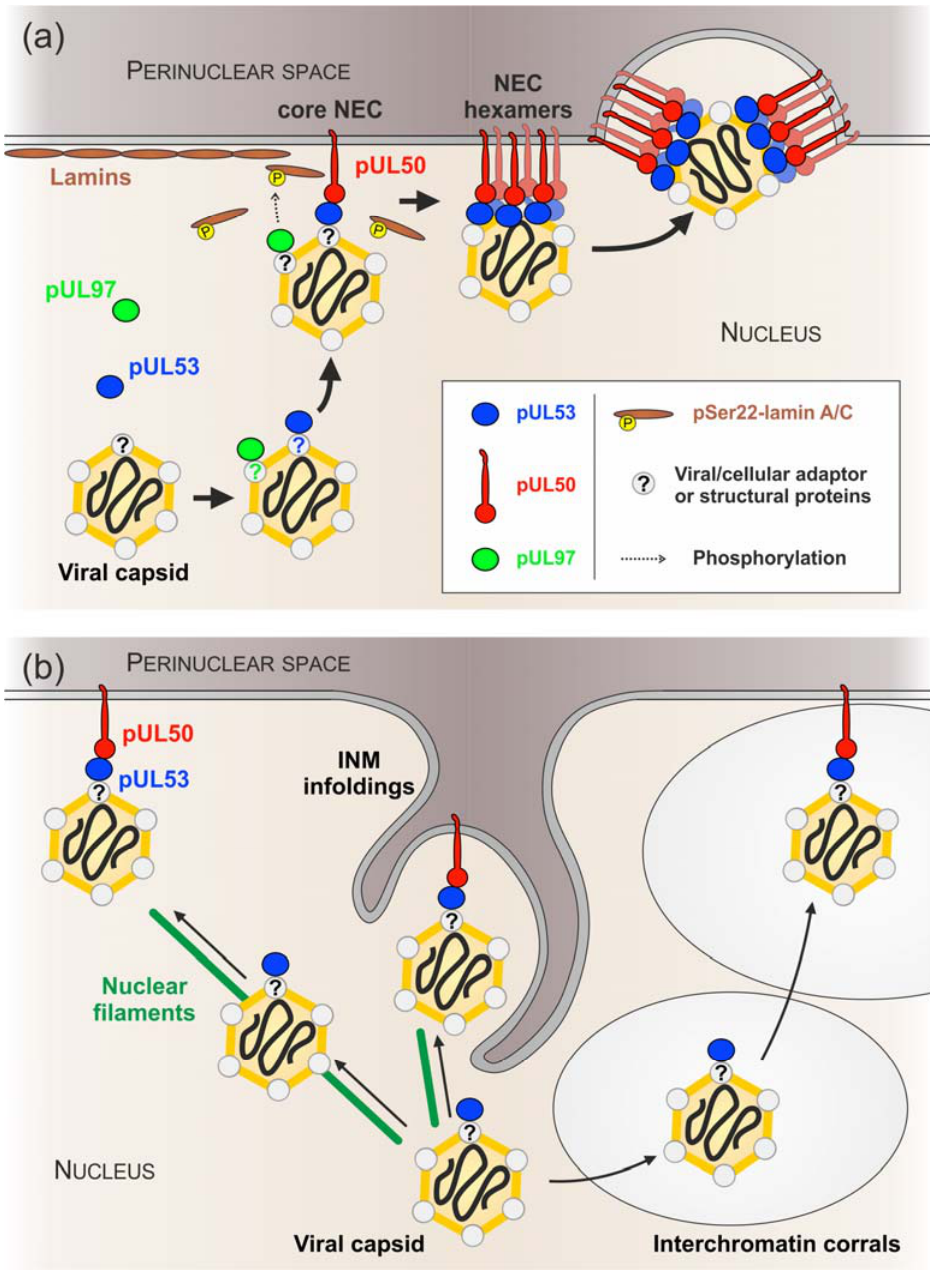
Figure 7. Schematic presentation of theoretical options that may lead to the recruitment of HCMV capsids to INM budding sites. ( a ) First, core NEC component pUL53 and NEC-associated protein kinase pUL97 bind to viral capsids in the nucleoplasm. Binding might be mediated directly via structural viral proteins (e.g., MCP, SCP, pUL85, or CVSC proteins) or indirectly via viral or cellular adaptor proteins. Second, pUL53-coated capsids dock to membrane-anchored pUL50 under formation of the core NEC. Capsid-associated pUL97 might be responsible for phosphorylation of remaining lamin A/C molecules providing access to the INM. Hexameric core NEC assemblies finally initiate budding into the perinuclear space; ( b ) Depiction of putative mechanisms of how HCMV capsids reach the INM are depicted on the basis of evidence mainly provided by this study and studies with alpha-herpesviruses. Black solid arrows define optional directions of capsid transport/trafficking. See description of individual possibilities in the main text. Diagrams not to